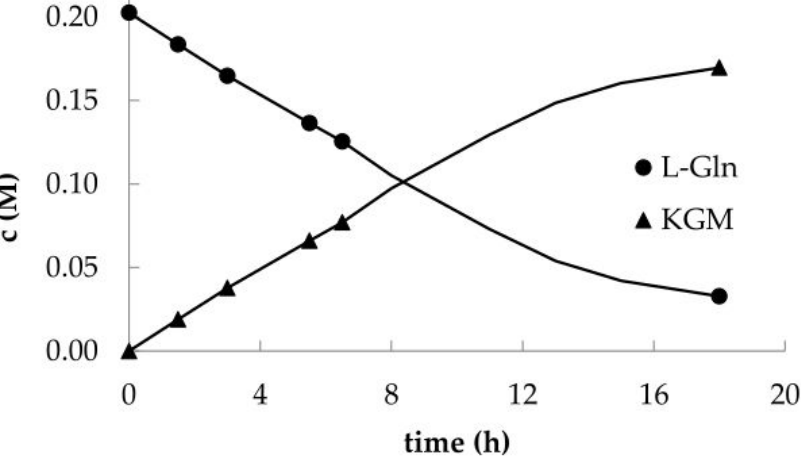
Figure 4. Representative kinetics of preparative production of α -ketoglutaramate by C. adamanteus L-amino acid oxidase-catalyzed reaction (37 ◦ C, pH 7.4, 1 mg/mL) in the presence of catalase (0.03